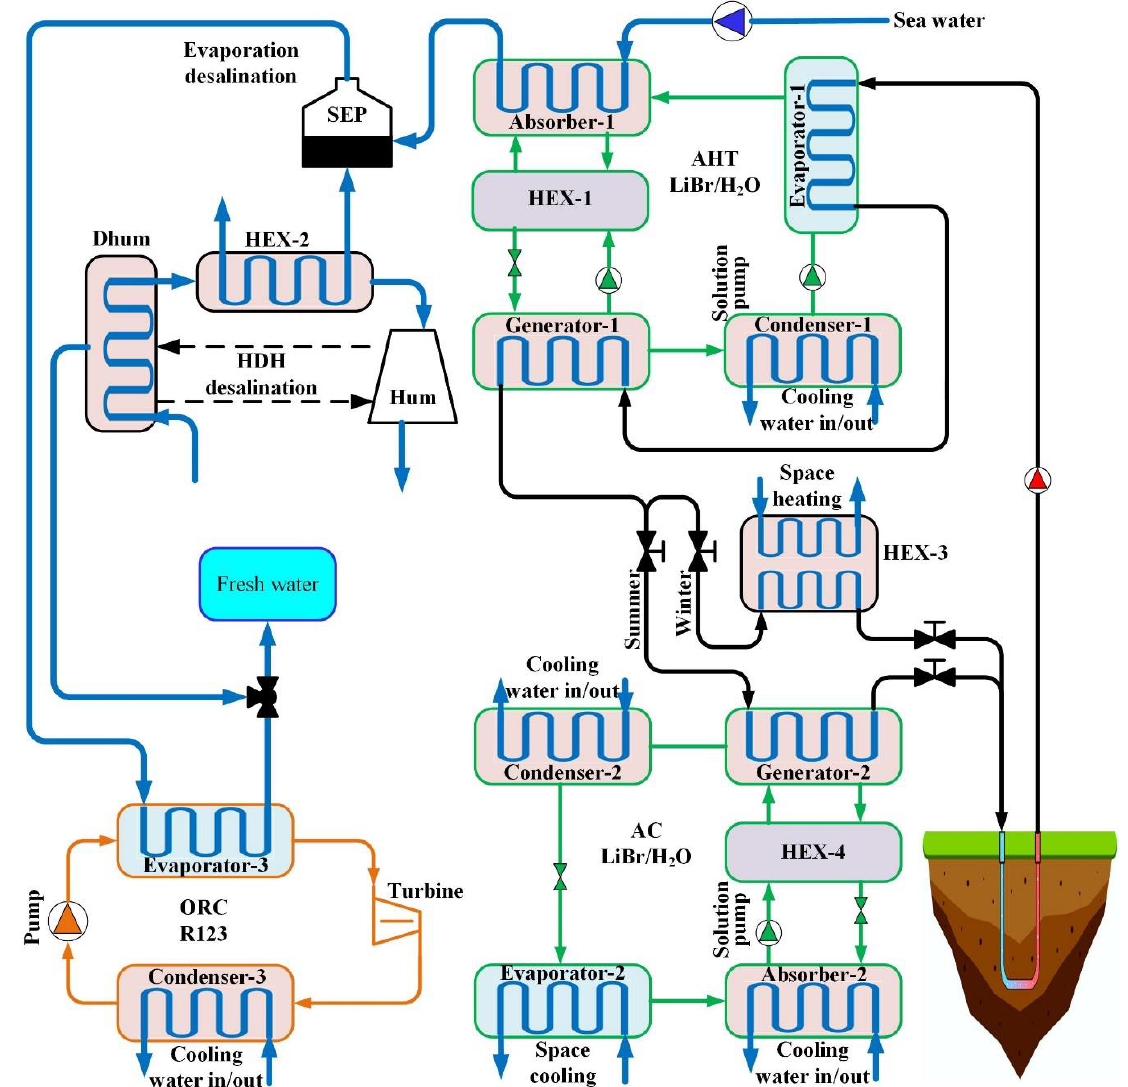
Figure 10. A schematic of the HDH-ABR system (adapted from [106]).